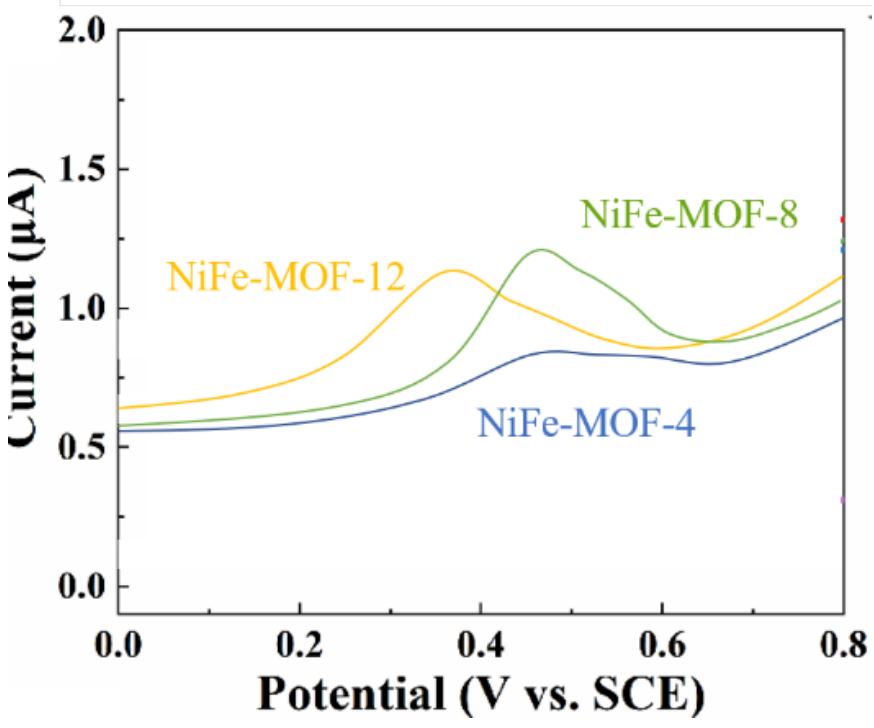
Figure 8. DPVs of NiFe-MOF-X.